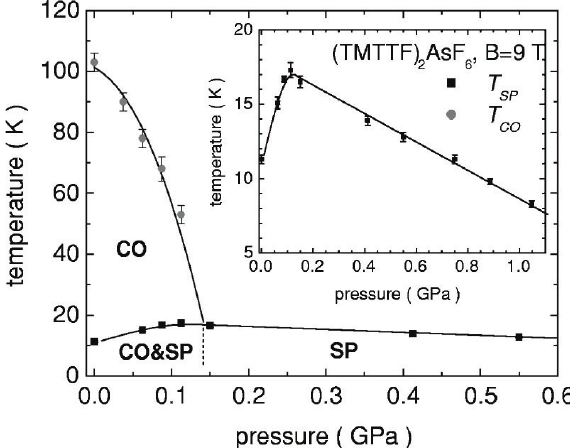
Figure 11. Critical temperatures of spin-Peierls and charge ordered states as a function of applied pressure in (TMTTF) 2 AsF 6 , as determined from NMR experiments. From Zamborszky et al.